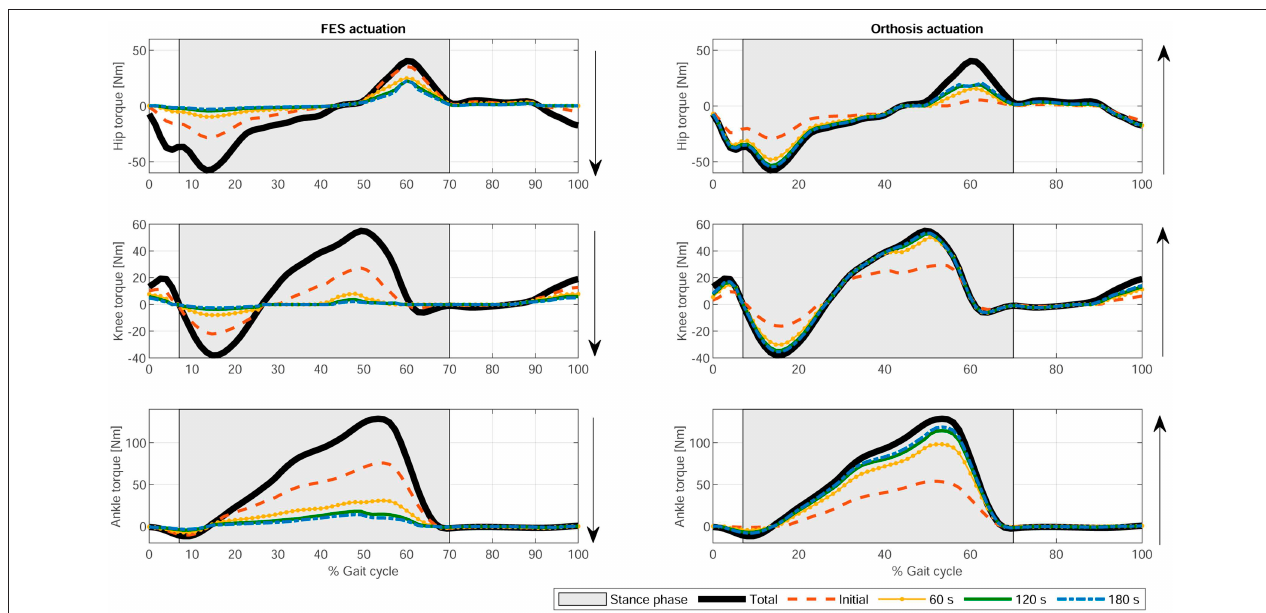
FIGURE 8 | Evolution of the electromechanical and FES actuation at the hip, knee, and ankle joints using exponential decay fatigue factor for function F 1 . Thick solid black line: Total joint torque. Dashed orange line: Initial joint torque. Dotted yellow line: Joint torque at 60 s. Solid green line: Joint torque at 120 s. Dash-dotted blue line: Joint torque at 180 s.